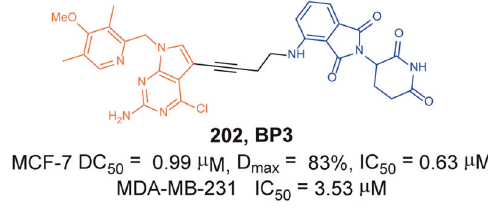
Fig. 57 The representative PROTAC targeting